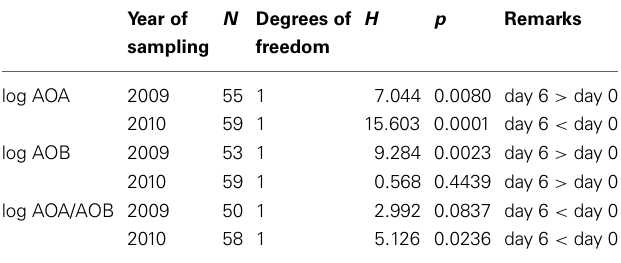
Table 3 | Effect of incubation on the numbers of ammonia-oxidizing archaea and bacteria and their mutual ratio according to a nonparametric Kruskal-Wallis